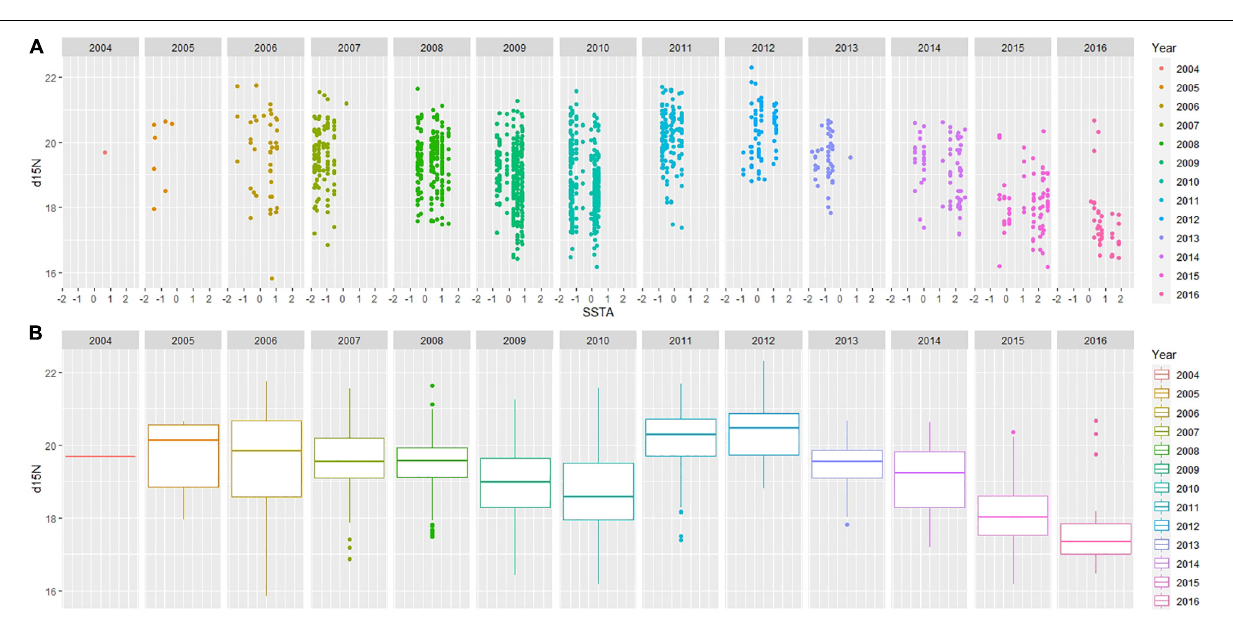
FIGURE 4 | (A) Mixed Linear Effects ggplot of Model 2. δ 15 N measured in parts per thousand